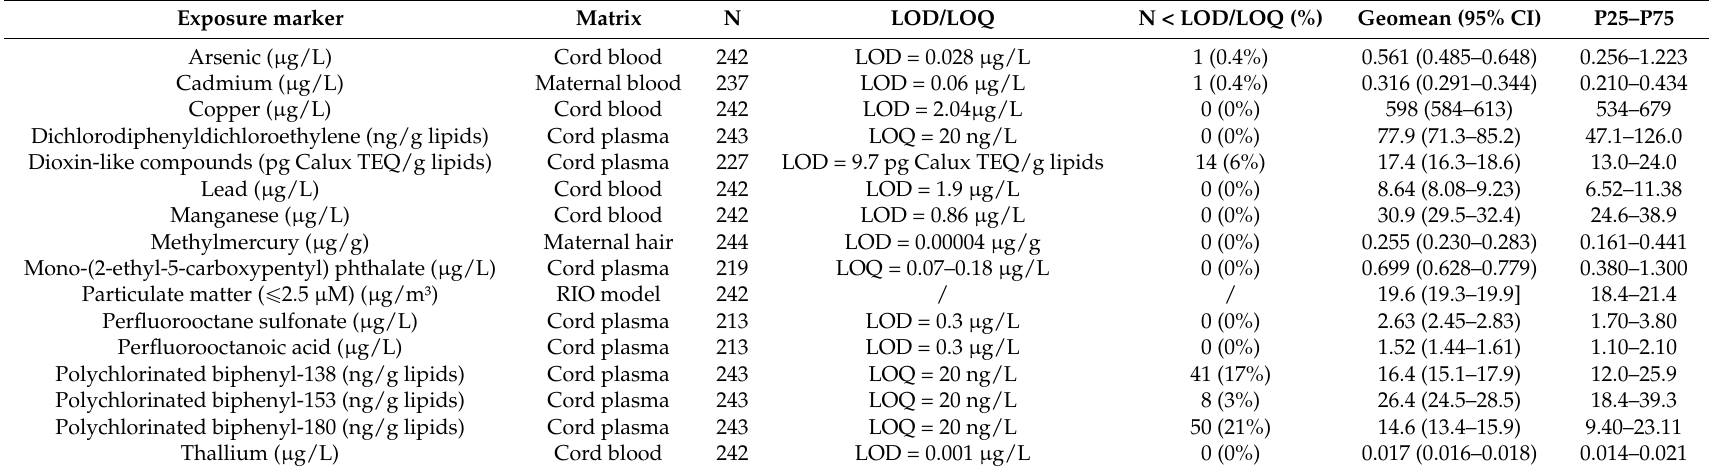
Table 2. Exposure to environmental